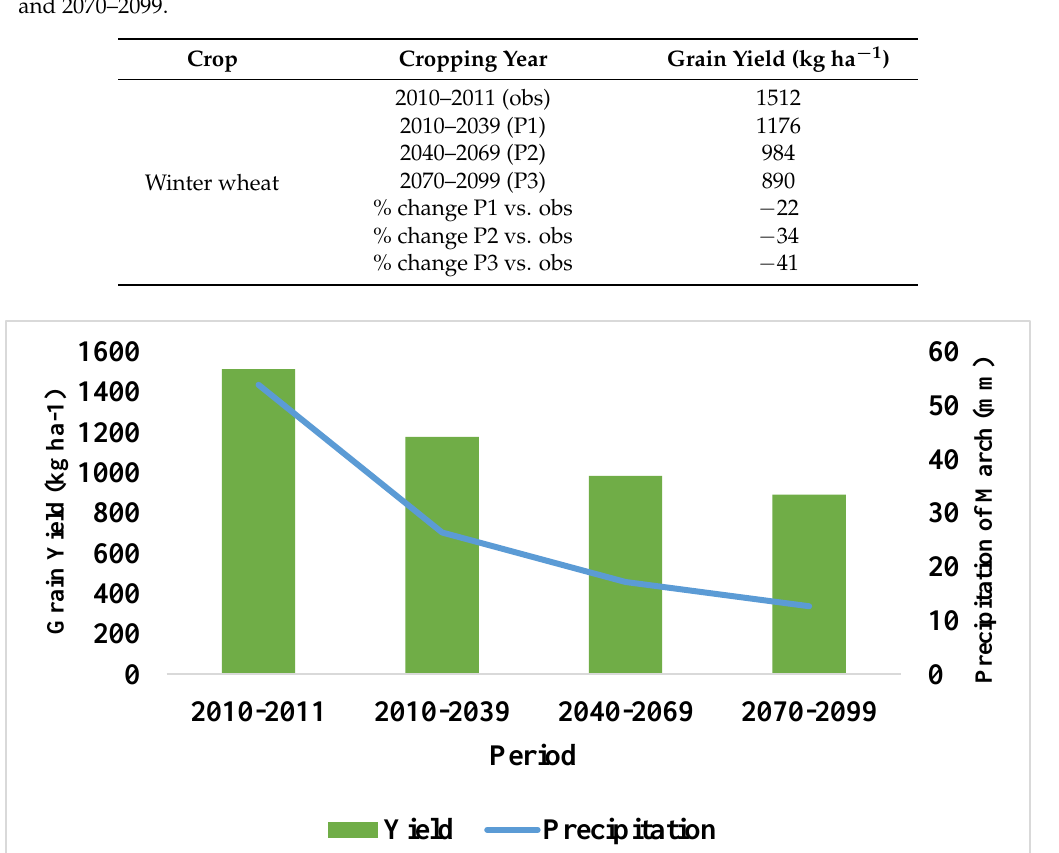
Figure 4. Relationship between the yield reduction and rcp2.6-induced precipitation of March in the three future periods.